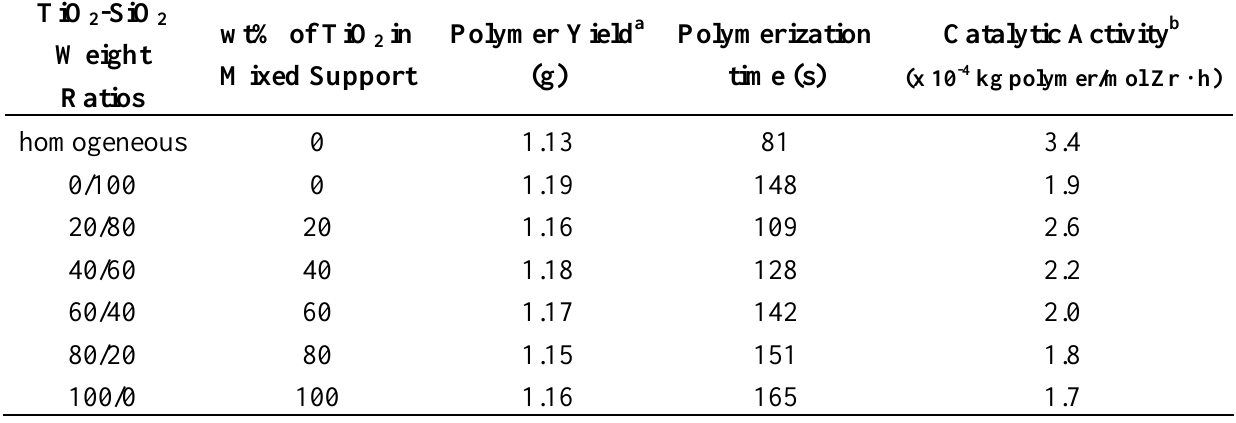
Table 1: Catalytic activities during ethylene/1-hexene copolymerization via TiO mixed oxides supported-MAO with zirconocene catalyst